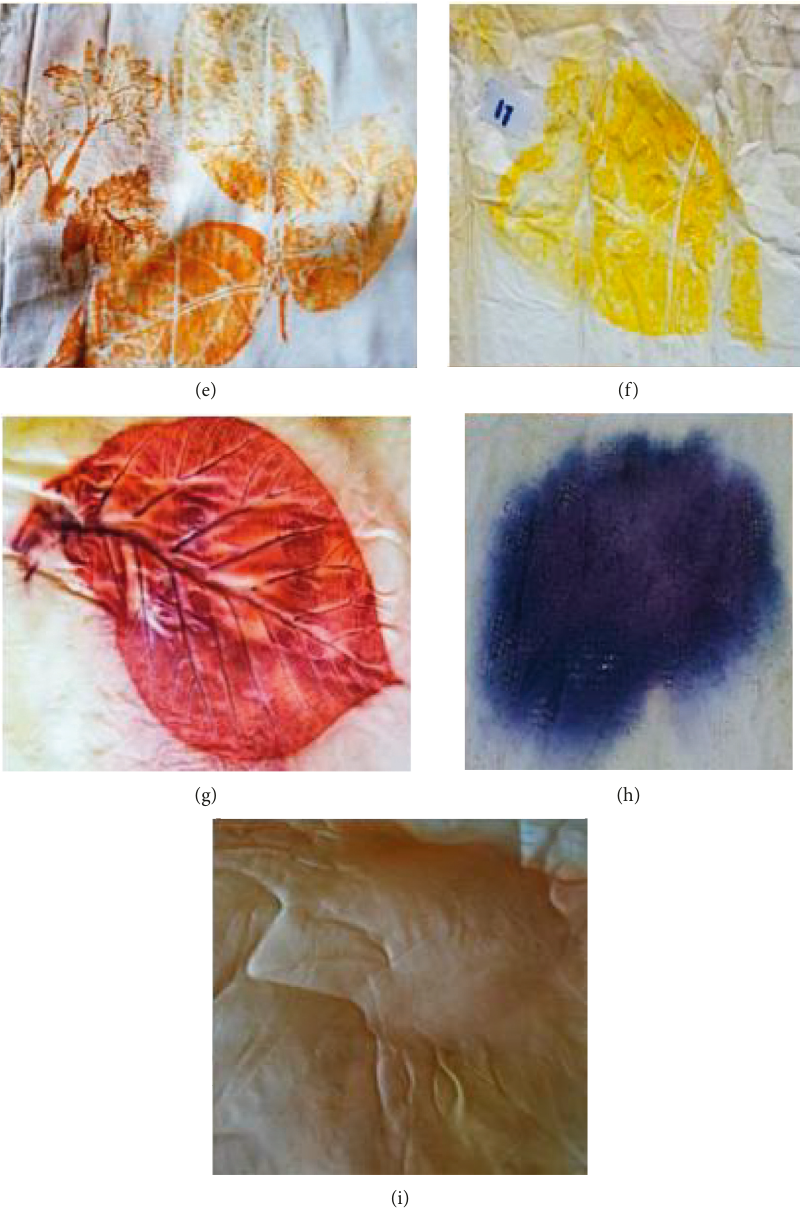
Figure 3: The samples that produce color: (a) Wrightia arborea (Dennst.) Mabb, (b) Gossypium arboreum L., (c) Acalypha wilkesiana Mull. Arg., (d) Polygonum barbatum L. (e) Oroxylum indicum (L.) Vent., (f) Antigonon leptopus Hook. & Arn., (g) Tecnona grandis L., (h) Hibiscus rosa-sinensis L., and (i). Nauclea orientalis